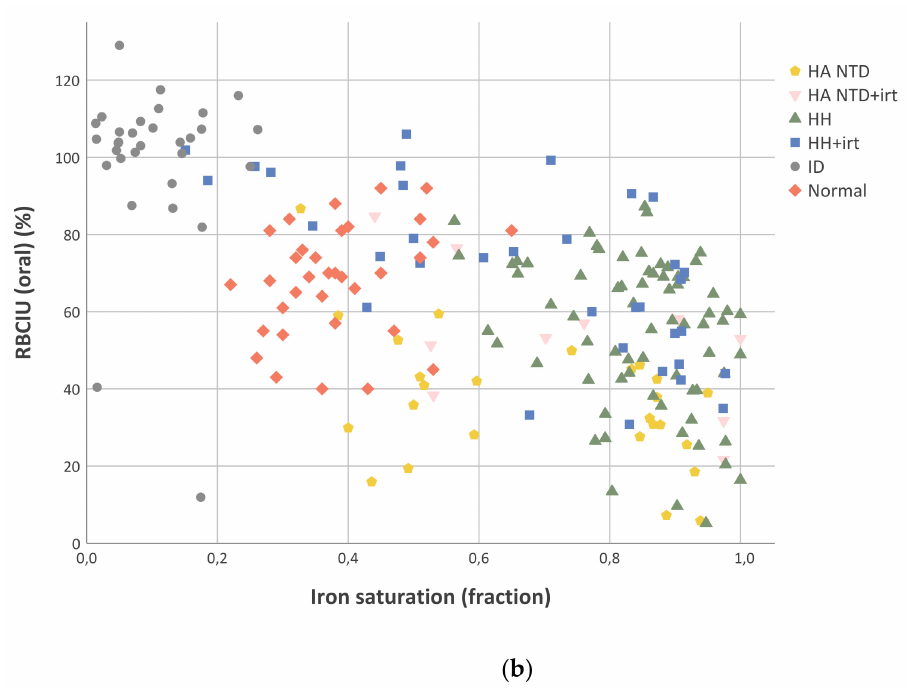
Figure 2. Red blood cell iron utilization (RBCIU). RBCIU was calculated from blood samples obtained 14 days after oral or intravenous iron test dose: RBCIU (oral) (%) = ( 59 Fe in 1 mL blood × blood volume (mL)) / 59 Fe retained in the body after oral iron dose × 100%, and RBCIU (intravenous) (%) = ( 59 Fe in 1 mL blood × blood volume (mL)) / 59 Fe iv dose × 100%. ( a ) Bar plot with mean percentages of RBCIU. Error bars represent 95% confidence intervals. * p < 0.01. ( b ) Scatter plot with iron saturation (x-axis) and RBCIU after oral iron (y-axis). Every dot represents a single analysis and is colored by diagnosis. HA NTD hereditary anemia non-transfusion dependent; HH hereditary hemochromatosis; ID iron deficiency; irt iron reducing therapy (phlebotomies or